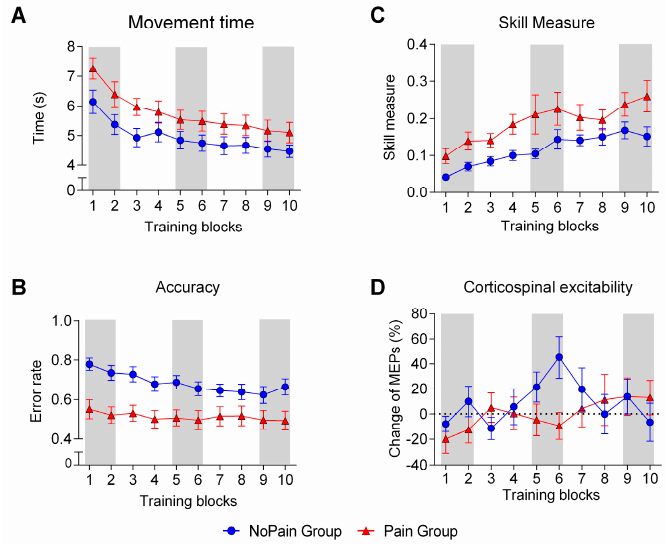
Figure 4. Changes in behavioral and neurophysiological variables over time for each group . ( A ) shows the time course of changes in Movement time (average time needed to perform a sequence); ( B) presents the time course of changes in Accuracy (average error rate per block of 15 sequences); ( C ) depicts the time course of changes in Skill Measure (an index calculated to take into account the speed-accuracy trade-off); ( D ) illustrates the time course of changes in corticospinal excitability, measured with single pulse TMS. The NoPain group is represented by blue circles and the Pain group by red triangles. Shaded areas indicate the time periods that were used for statistical analysis: Early (training blocks 1 and 2), Mid (training blocks 5 and 6), and Late training (training blocks 9 and 10).